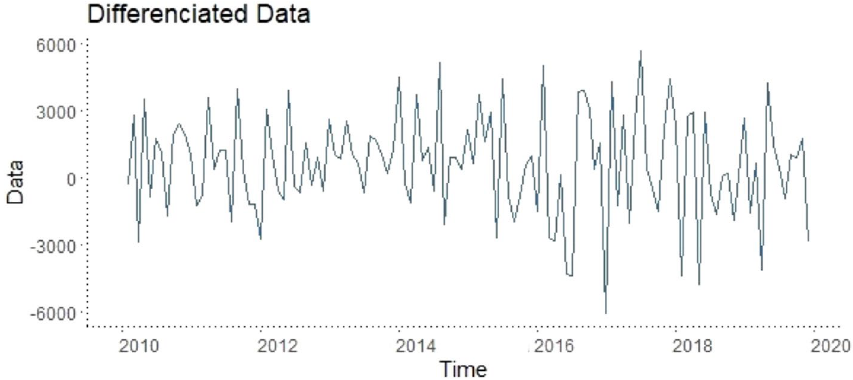
Figure 4. Graphical representation of the series of air traffic data for the years 2010–2019 after applying the differentiation process.